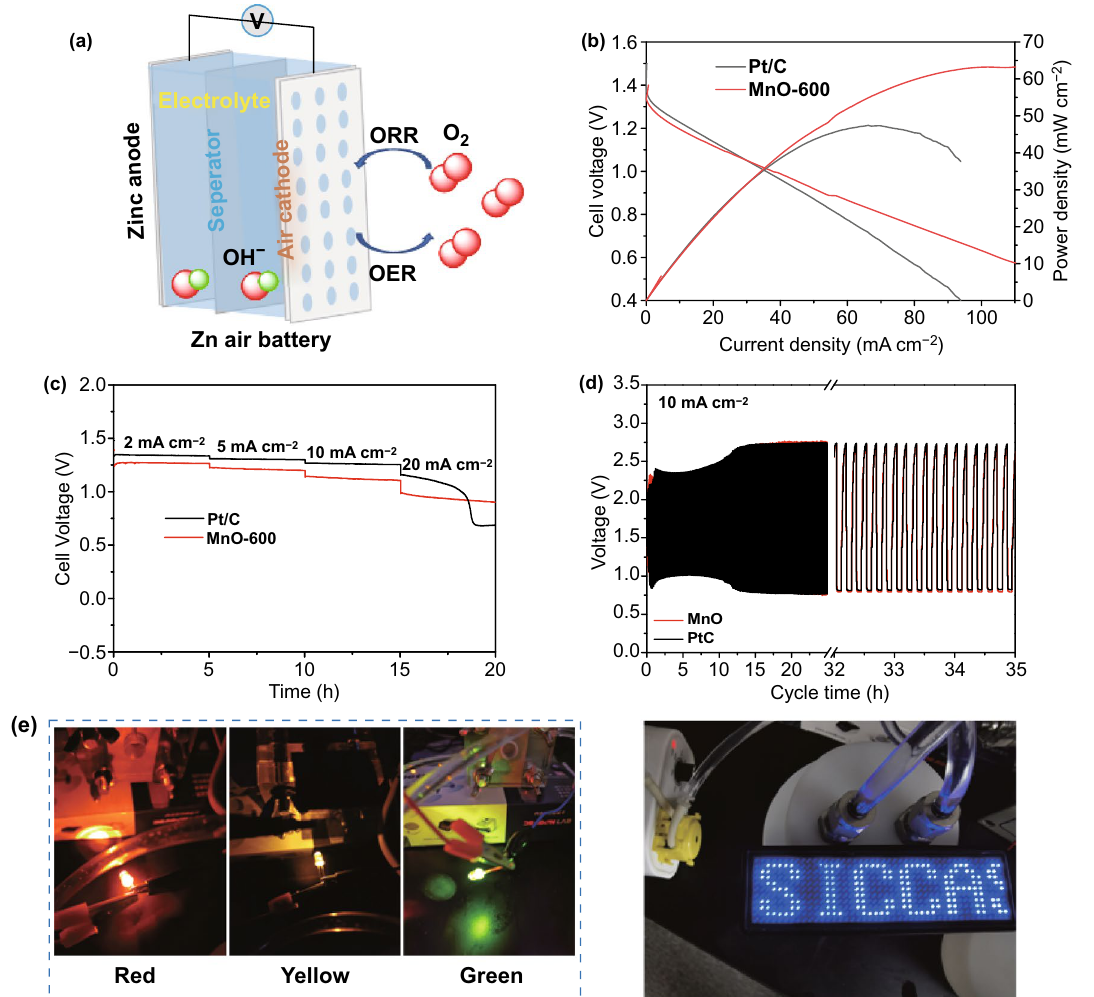
Fig. 5 a Schematics of the primary configuration of a Zn–air battery. b Polarization curves of zinc–air battery based on MnO-600 or commer- cial Pt/C catalyst as cathode: cathode area: 3 cm 2 ; loading amount: 2 mg cm −2 ; temperature: ~ 20 °C; c longtime durability of zinc–air battery by using MnO-600 or commercial Pt/C as cathode catalyst at the current densities of 2, 5, 10 and 20 mA cm −2 . d Galvanostatic discharge–charge cycling curve at 10 mA cm −2 of the zinc–air battery using MnO-600 or Pt/C catalyst. e Photographs of different light-emitting diode (1.5